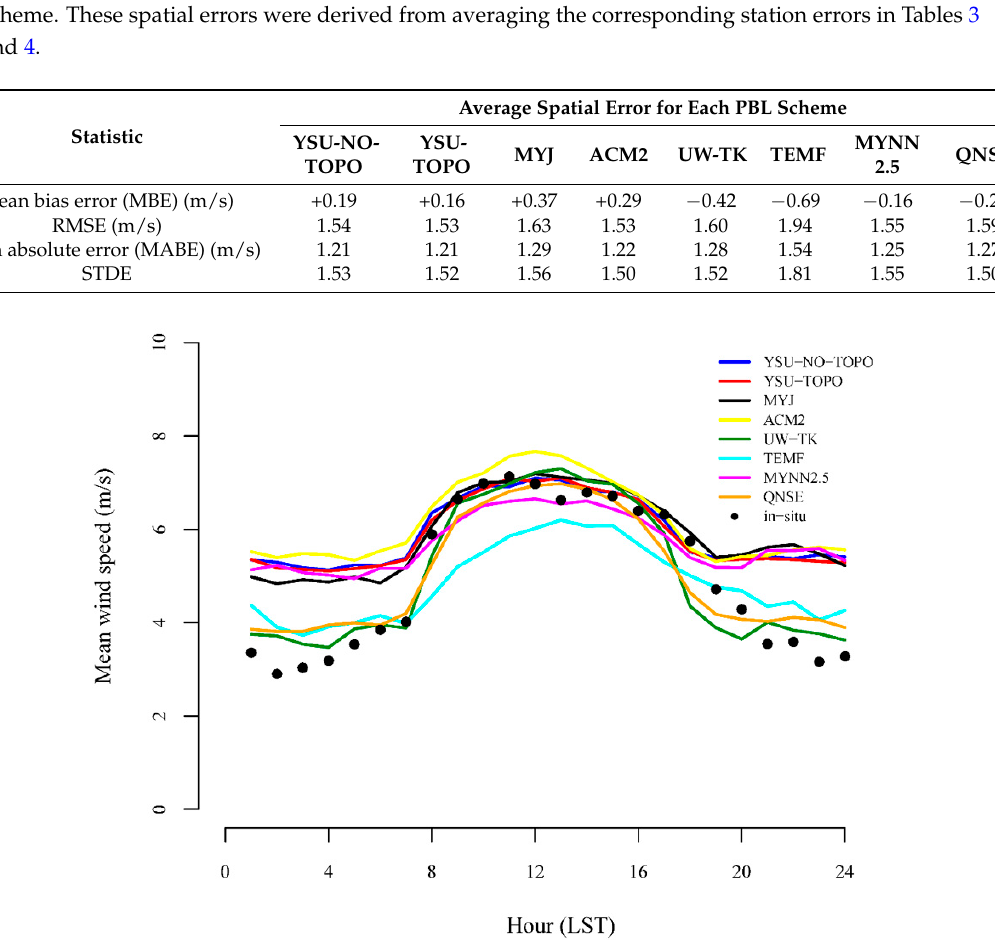
Figure 14. Diurnal variation in 10 m level wind speed as simulated by 7 PBL schemes and compared with in-situ observations at Crown Point.